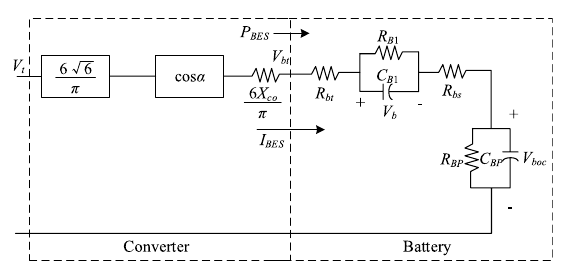
Fig. 3 The equivalent circuit model of